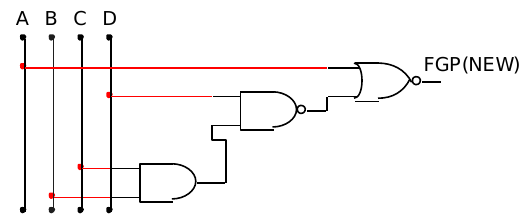
Figure 15. Repairing circuit for F 5 (F GP (NEW) ) .